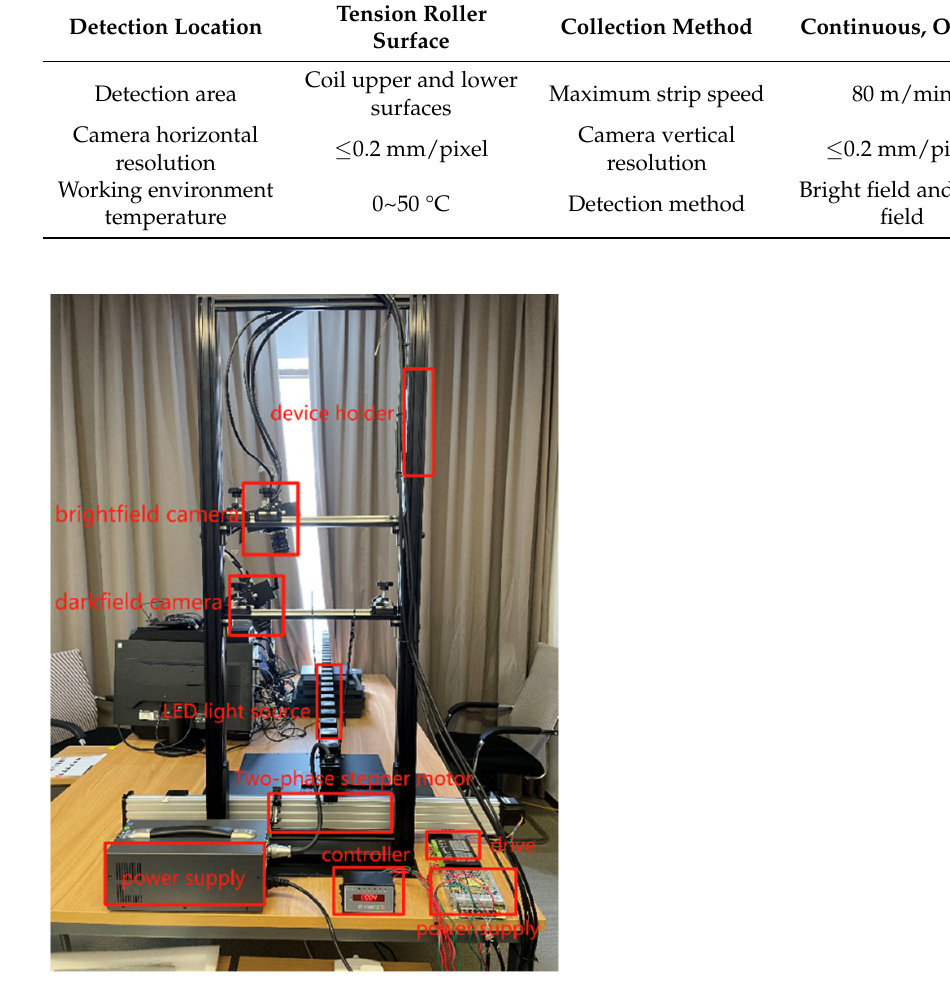
Figure 7. The experimental setup.